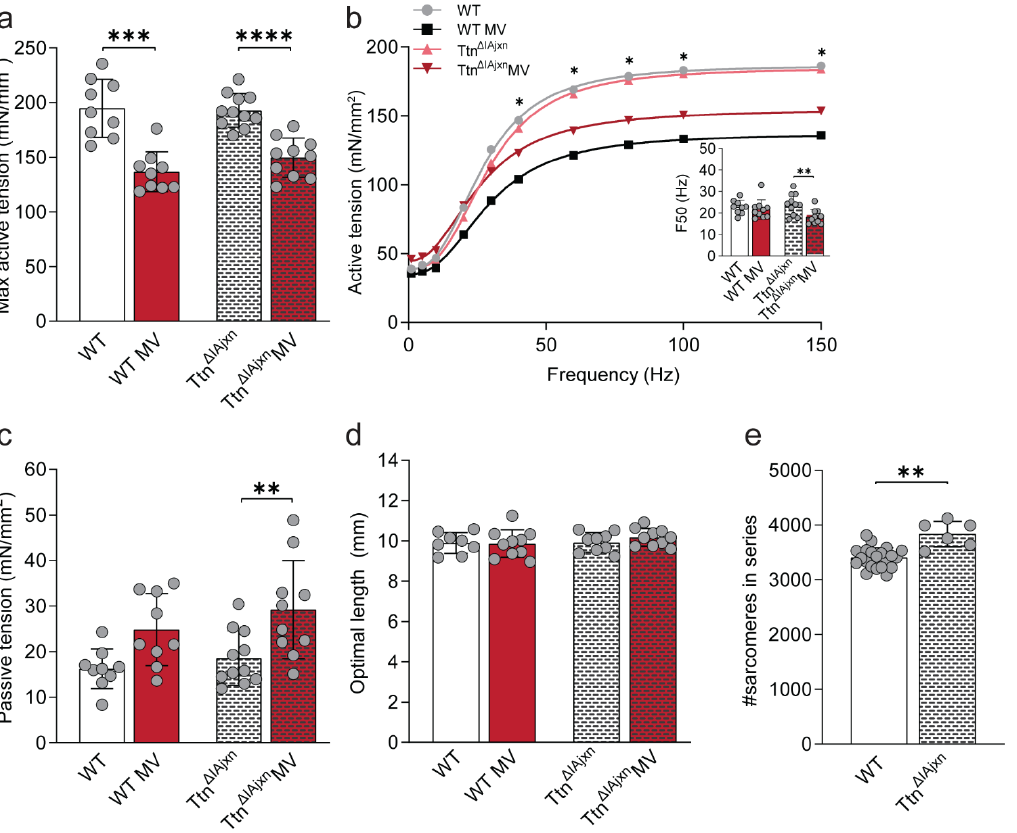
Figure 3. Effects of mechanical ventilation on muscle function in the Ttn ∆ IAjxn mouse diaphragm. ( a ) Maximal active tension of non-ventilated and ventilated WT and the Ttn ∆ IAjxn mice. ( b ) Fitted curves for tension-stimulation frequency relations. F50 (inset) was determined as the absolute EC50 of the curve, and represents the frequency required to develop 50% of maximal force. Asterisks indicate a significant reduced force in mechanical ventilated animals compared to their respective non-mechanically ventilated controls. ( c ) Passive tension measured at optimal length in non-ventilated and ventilated WT and Ttn ∆ IAjxn mice. ( d ) Optimal diaphragm strip length, i.e., the length representing maximal cross bridge binding required for maximal force production. ( e ) Number of sarcomeres in series. Bars represent mean ± SD. * p < 0.05, ** p < 0.01, *** p < 0.001, **** p < 0.0001. WT = wild type, MV = mechanically ventilated. Each dot represents a single animal and animals are only presented in each graph